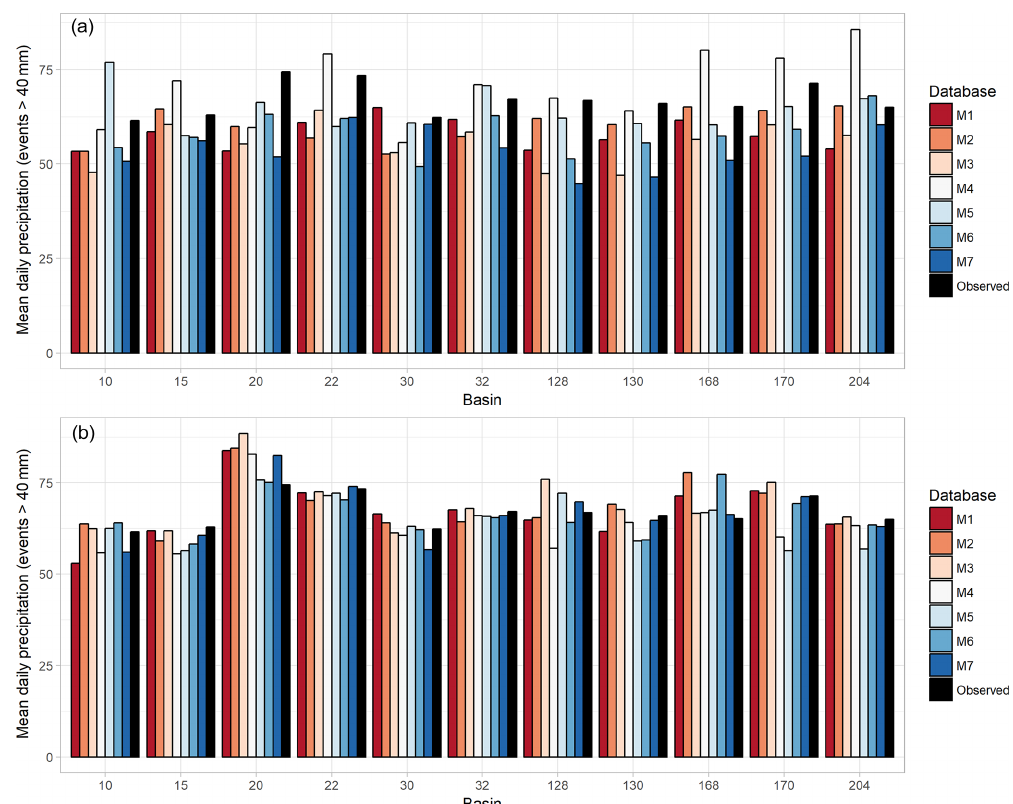
Figure 3. Comparison of the mean precipitation value (cases with average daily precipitation exceeding 40mm) for each basin of the Valencian Community between the observations and the different models with (b) and without (a) correction for the common period 1996– 2005. M1 to M7 refer to the seven EURO-CORDEX simulations used (Table 1). The numbers on the x axis indicate the code of each basin (see Table A2 in the